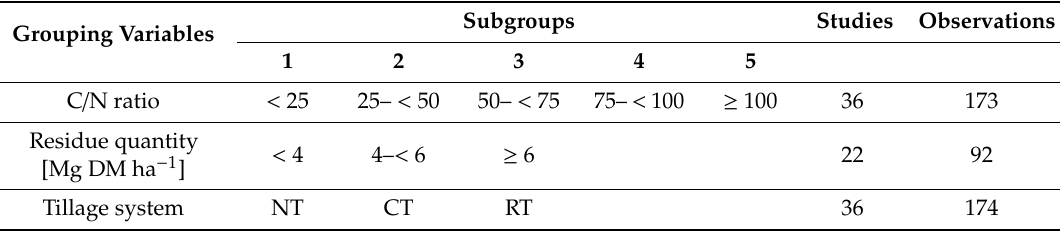
Table 3. Grouping variables and their subgroups used in meta-analysis focusing on crop residues removals e ff ects on N 2 O emission.